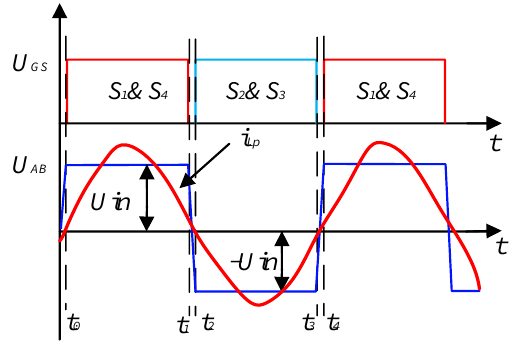
Figure 3. Operation waveform of the inverter.